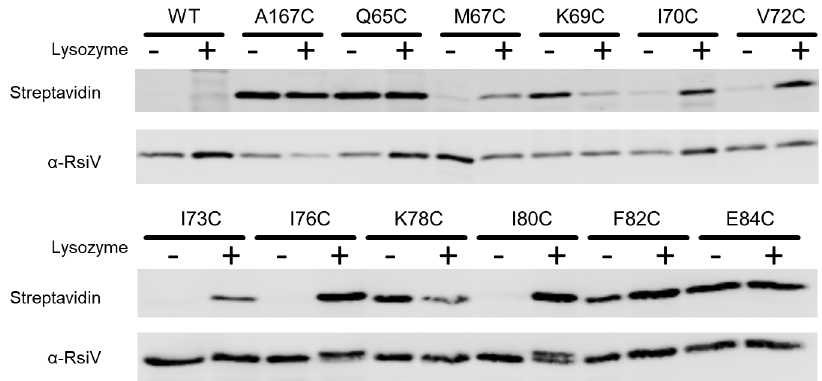
Fig 5. Hydrophobic residues are differentially labeled in lysozyme conditions. To allow affinity purification, RsiV was expressed with an N-terminal 6xHis-tag which does not alter RsiV function. An A66W mutation was introduced to prevent cleavage when incubated in the presence of lysozyme. Various residues (Q65, M67, K69, I70, V72, I73, I76, K78, I80, F82, E84) were mutated to a cysteine to probe their accessibility to a membrane-impermeable dye A167C was created as a positive control as it is located in the lysozyme binding pocket and expected to be outside of the membrane. Cells were grown to mid log and the SCAM assay was performed. The resulting purified products were analyzed by western blot with Streptavidin IR680LT to detect the MPB label and α -RsiV 59-258 antibodies to serve as a loading control.